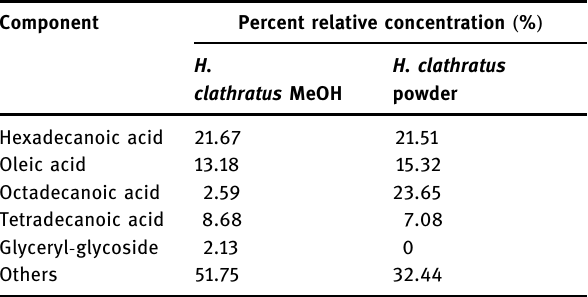
Table 1: Major components present in H. clathratus methanol extract and powder, and their percent relative concentration Component Percent relative concentration ( %